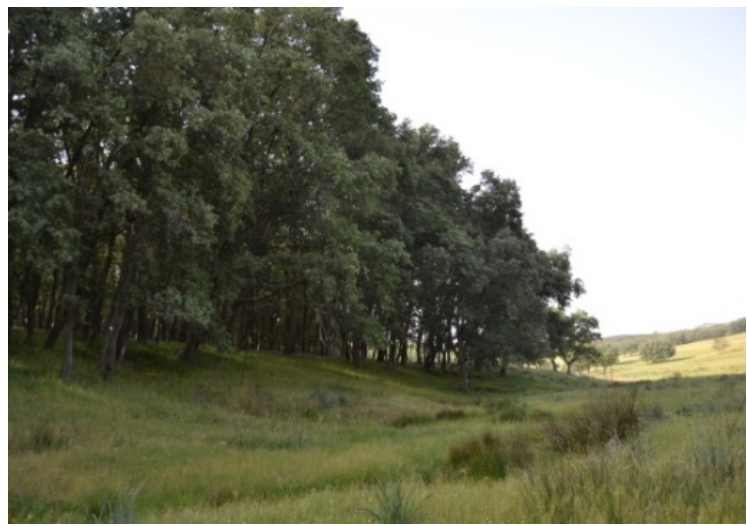
Figure 10. Mesomediterranean Pyrenean oak wood of Quercus pyrenaica in Sierra Morena (El Viso). Arbuto unedonis – Quercetum pyrenaicae.